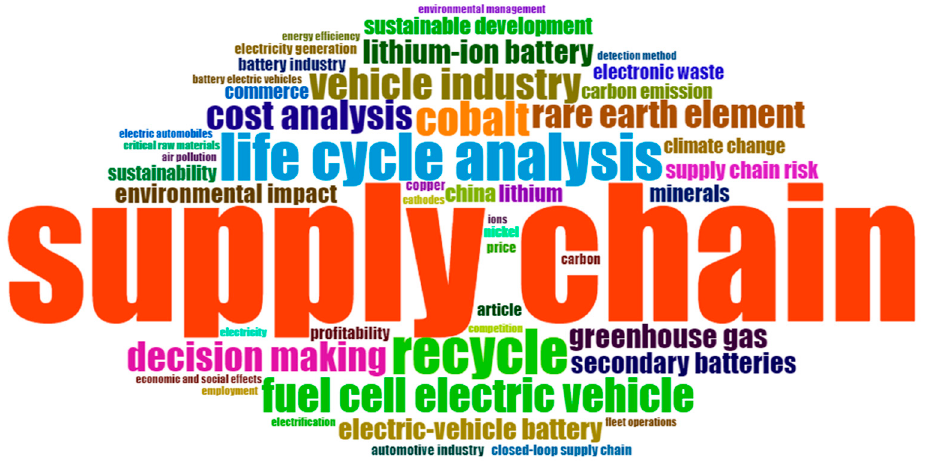
Figure 3. Co-occurrence of authors’ keywords. (Produced using the Bibliometrix software).